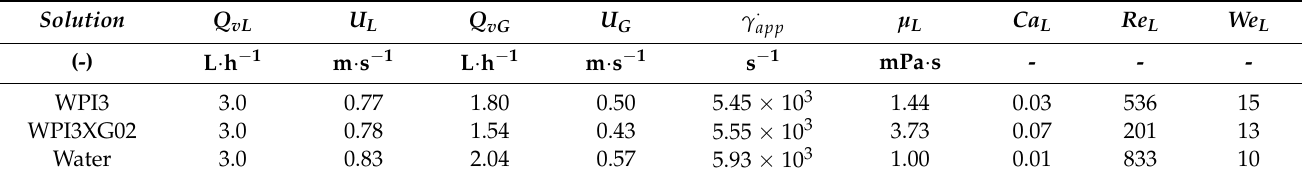
Table 7. Hydrodynamic parameters of the two-phase flow in the expansion channel of the microfluidic device CX-E-600 for the solutions WPI3, WPI3XG02 and water at Q vL = 3 L · h − 1 − Q mG = 5 g · h − 1 .